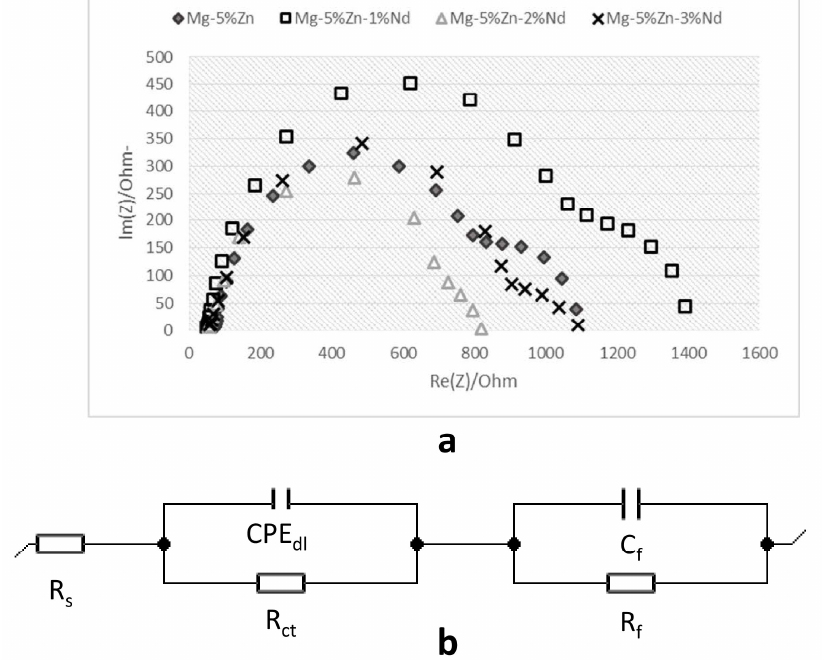
Figure 10. Electrochemical impedance spectra (EIS) analysis of all the tested alloys, ( a ) Nyquist plots obtained after immersion in PBS solution for up to 1 h. ( b ) Related equivalent circuit.